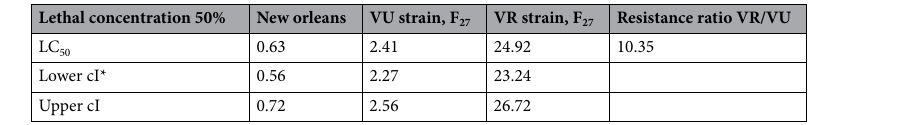
Table 1. Resistant vs susceptible strains—LC 50 for permethrin treatment. *cI, confidence interval of µg permethrin